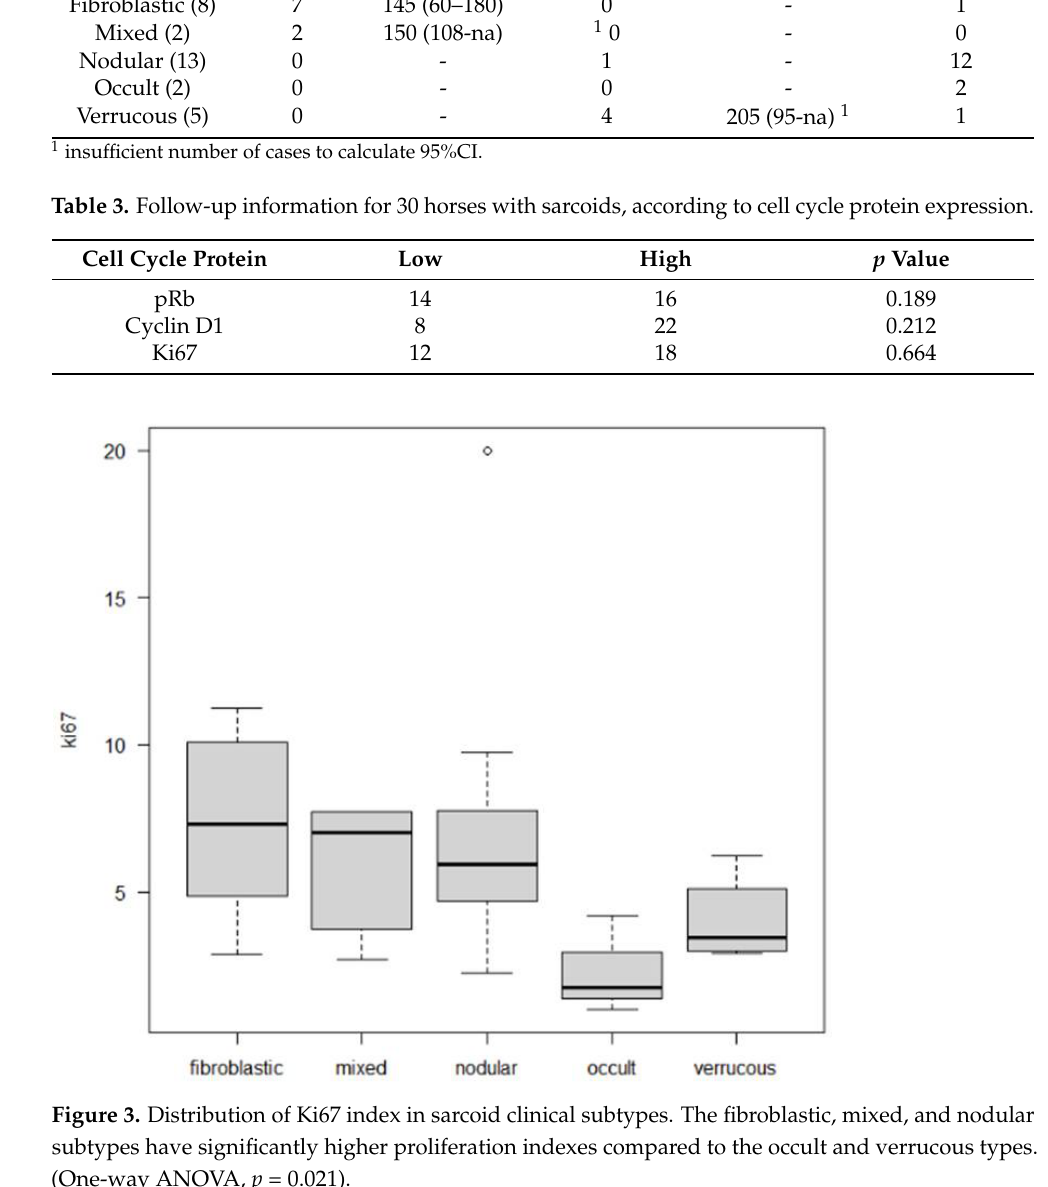
Table 3. Follow-up information for 30 horses with sarcoids, according to cell cycle protein expression.